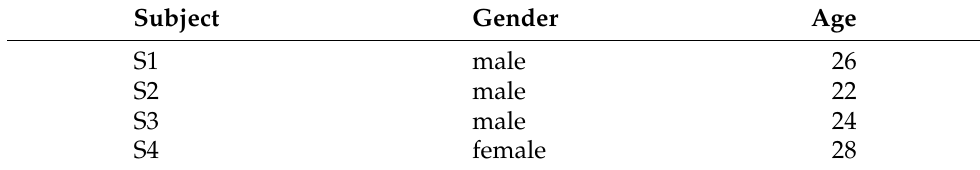
Table 1. Summary of the subjects participated in experiments in terms of gender and age.